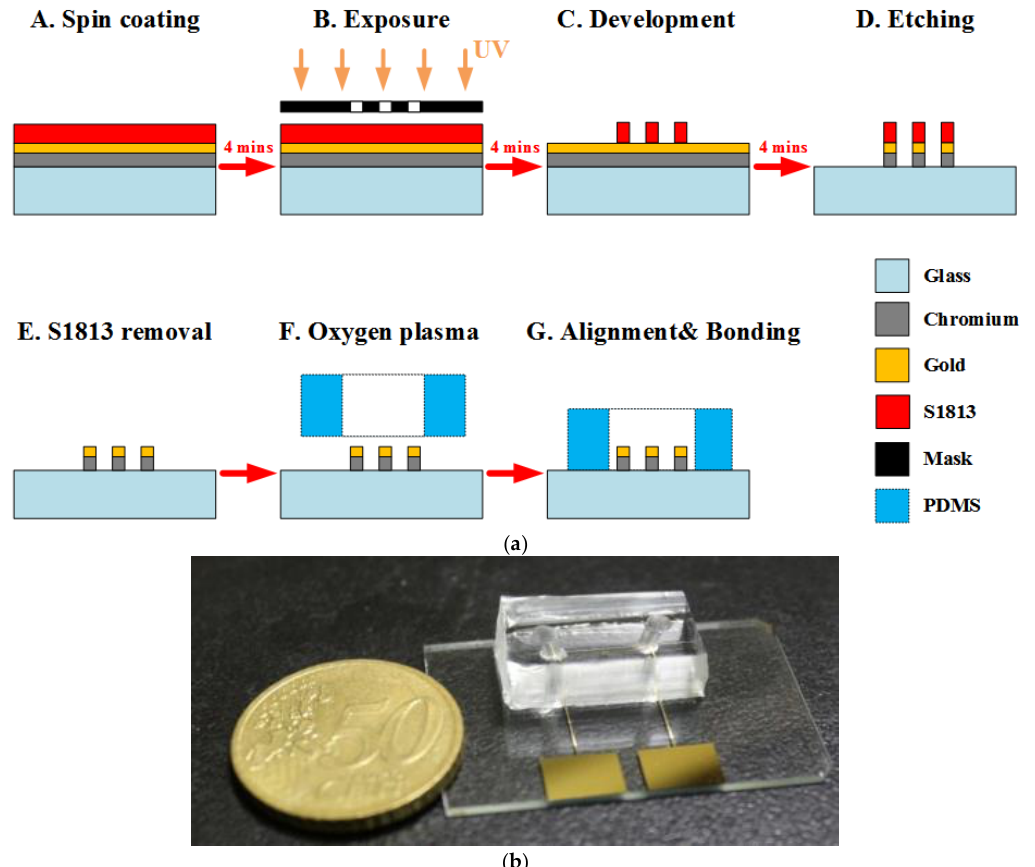
Figure 2. ( a ) The fabrication process of the chip. ( b ) Photograph of a fabricated microchip using the standard photolithography process.